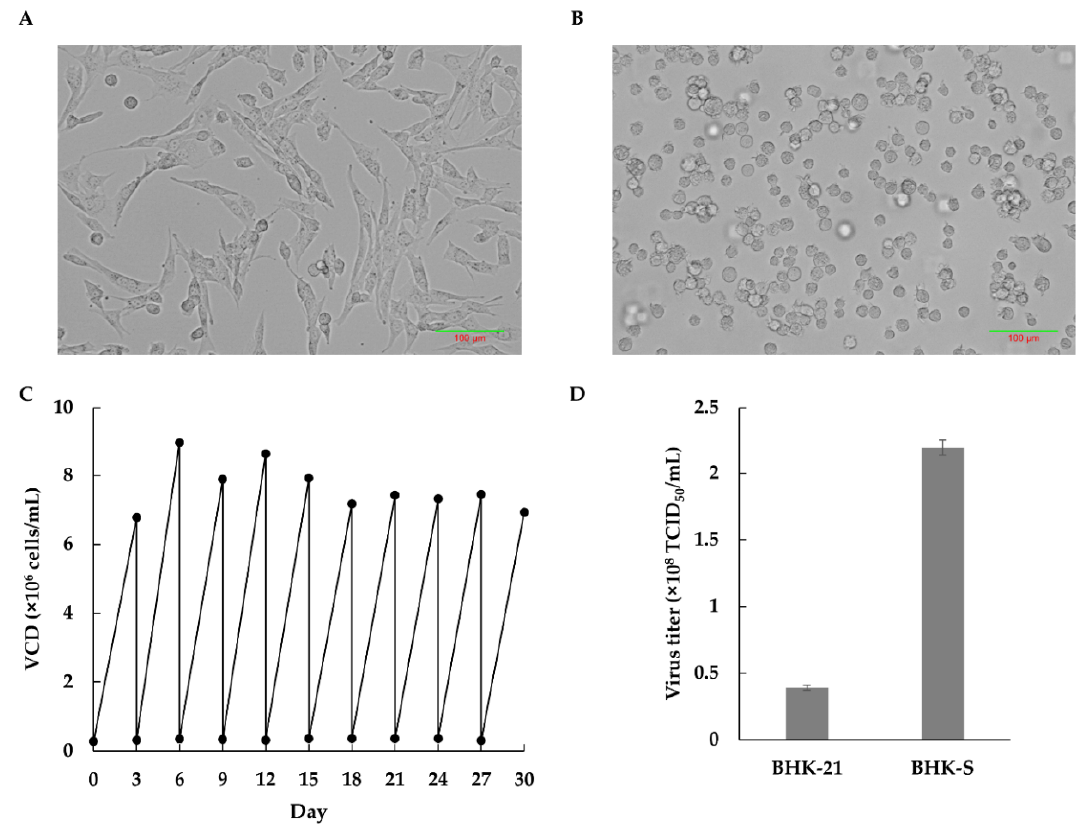
Figure 1. Morphologies of adherent BHK-21 (C13) cells in a T-flask ( A ) or BHK-S cells as suspension cultures in a 125 mL Erlenmeyer flask ( B ). The stability of the BHK-S cells was monitored for 3 weeks ( C ). The cell viability exceeded 95% at each passage. Production of FMDV by BHK-21 and BHK-S cells was compared using the same culture volume ( D ). Each experiment was carried out in triplicate. Data expressed as mean ± standard deviation.